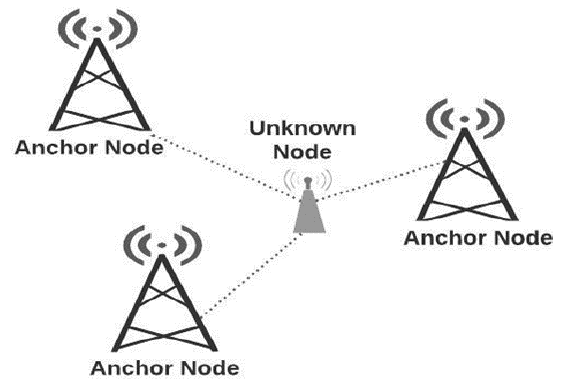
Figure 4. Time of arrival.